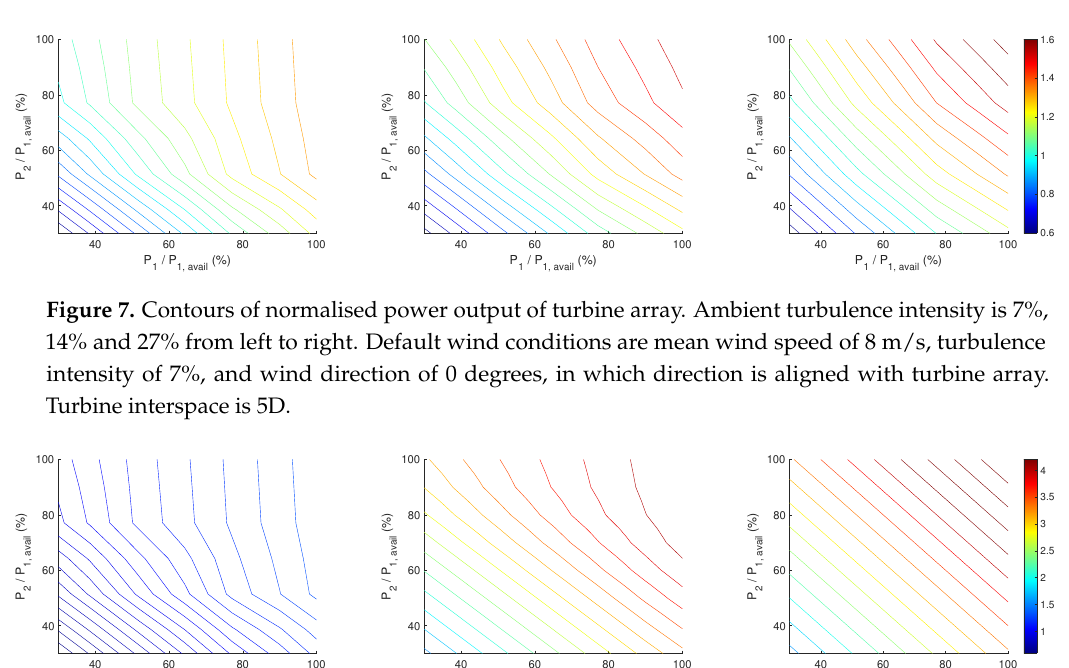
Figure 6. Contours of normalised power output of turbine array. Wind direction is 0, 10 and 22 degrees from left to right. Default wind conditions are mean wind speed of 8 m/s, turbulence intensity of 7%, and wind direction of 0 degrees, in which direction is aligned with turbine array. Turbine interspace is 5D.